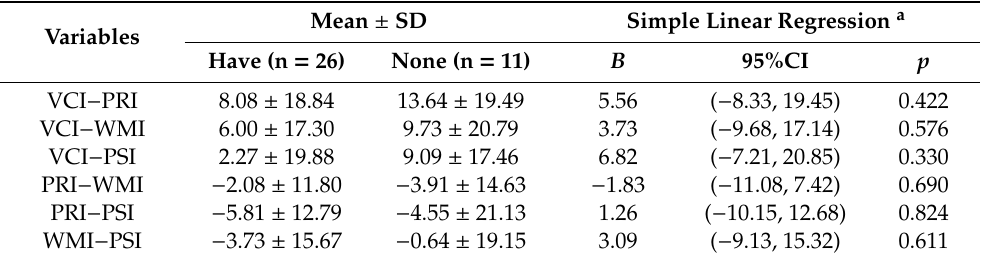
Table 8. The regression analysis between subtest-level discrepancy and near stereoacuity in the exotropia